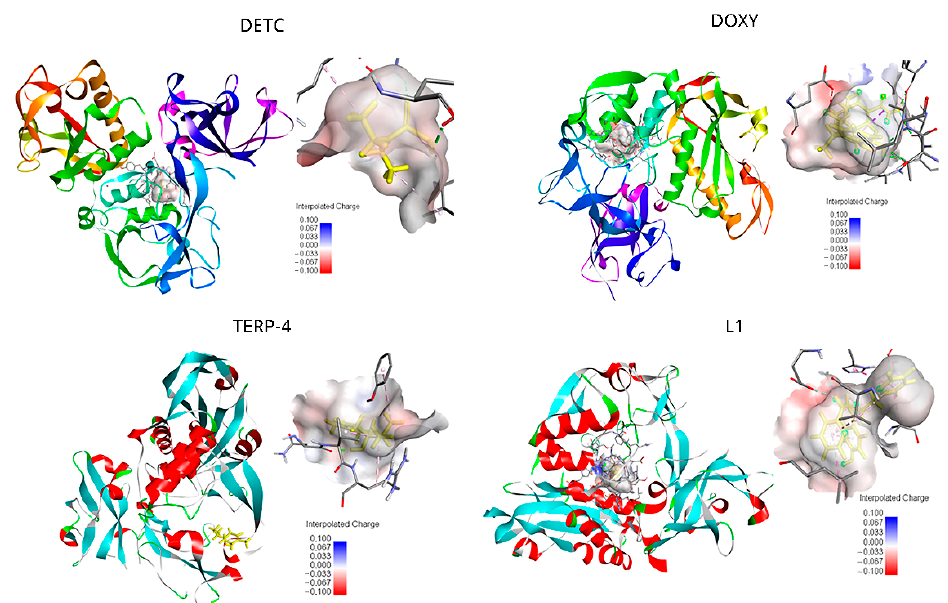
Figure 1. Active site of the Leishmania major glycoprotein of 63 kDa (gp63) in complex with di-